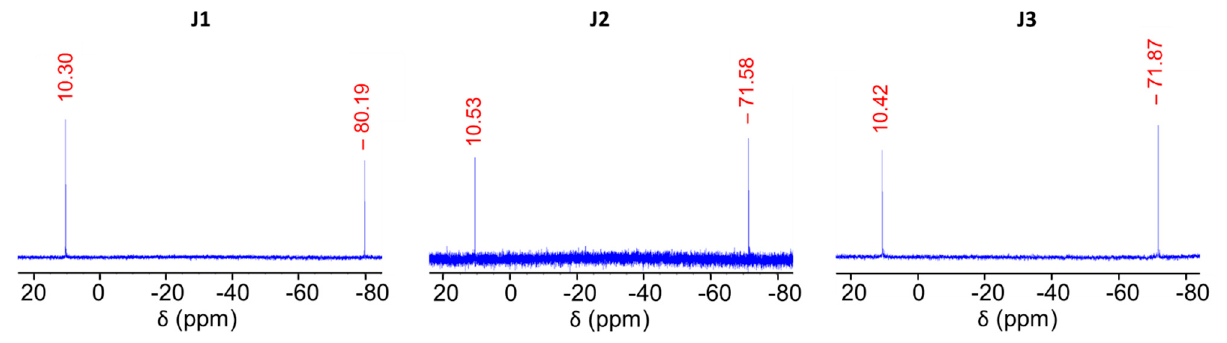
Figure 5. 29 Si NMR spectra of J1 , J2 and J3 (CDCl 3 ).